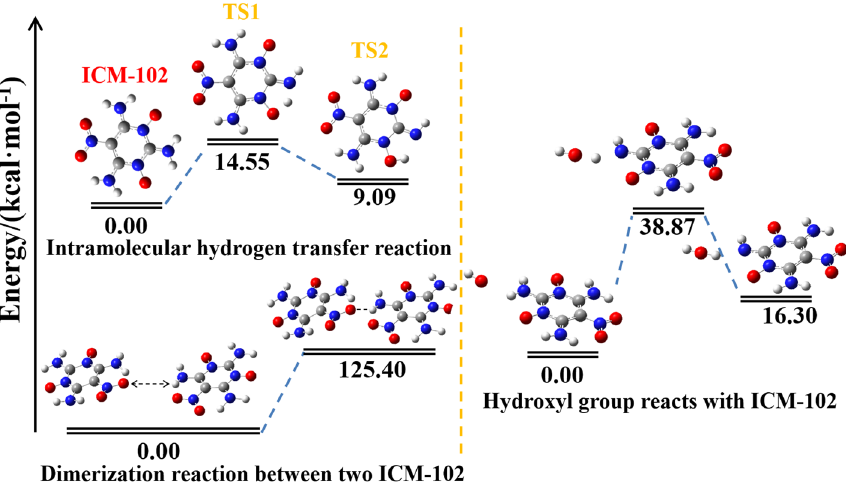
Figure 4. Energy barrier of the initial reaction pathway.